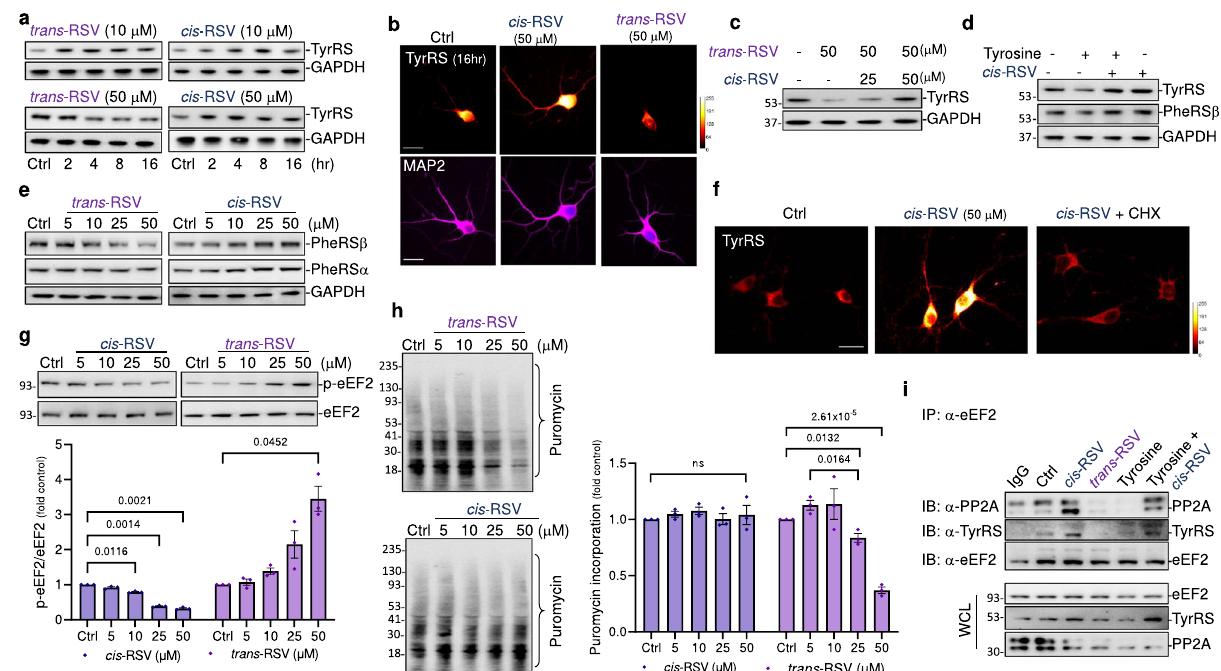
Fig. 3 Tyrosine and cis -RSV modulate the de novo synthesis of TyrRS at the elongation step of protein synthesis. a Low and high concentrations of trans- RSV (10 and 50 μ M) have opposite effects on TyrRS, and low concentration trans-RSV mimics cis-RSV . Representative immunoblots for TyrRS after treatment with cis -and trans -RSV (10 and 50 μ M) in rat cortical neurons (DIV 9). b cis-and trans-RSV have opposite effects on TyrRS . Representative spectral images (scale bar, 20 µ m) of TyrRS in rat cortical neurons (DIV 10) following treatment with either cis -RSV or trans -RSV for 16 hr (MAP2 – neurite, magenta; DAPI – nucleus, blue; TyrRS – red-yellow spectral image). c cis-RSV protects neurons against trans-RSV-mediated decrease in TyrRS . Representative immunoblots showing TyrRS after treatment with trans -RSV (50 μ M) alone or combined with different doses of cis -RSV for 4 hr. d cis-RSV protects neurons against tyrosine-mediated depletion of TyrRS . Cortical neurons were treated with Tyr (200 μ M) alone or combined with cis -RSV for 8 hr. e cis- and trans-RSV have opposite effects on neuronal PheRS β . Representative immunoblots for PheRS α / β after treatment with cis -and trans -RSV (5 – 50 μ M) for 4 hr. f cis-RSV stimulates the de novo synthesis of TyrRS . Spectral images (scale bar, 20 µ m) after treatment with cis -RSV (50 μ M) for 1 hr either alone or combined with CHX (100 μ g). g cis- and trans-RSV have opposite effects on the phosphorylation of eEF2 . Representative immunoblots for p-eEF2 after treating with cis - and trans -RSV (5 – 50 μ M) for 8 hr. h trans-RSV inhibits global protein synthesis . Cortical neurons were treated with cis -and trans -RSV (5 – 50 μ M) for 1 hr, followed by puromycin incorporation and detection using anti-puromycin antibody. i cis-RSV facilitates the interaction of PP2A with eEF2 . Cortical neurons were treated with cis - and trans -RSV (50 μ M) or Tyr (200 μ M) either alone or combined with cis -RSV for 4 hr. Immunoprecipitated eEF2 was probed for its interaction with PP2A and TyrRS. All data represent mean ± SEM for n = 3 experiments with signi fi cance measured using two-way ANOVA with Tukey ’ s test for multiple comparisons. Source data are provided as a Source Data fi